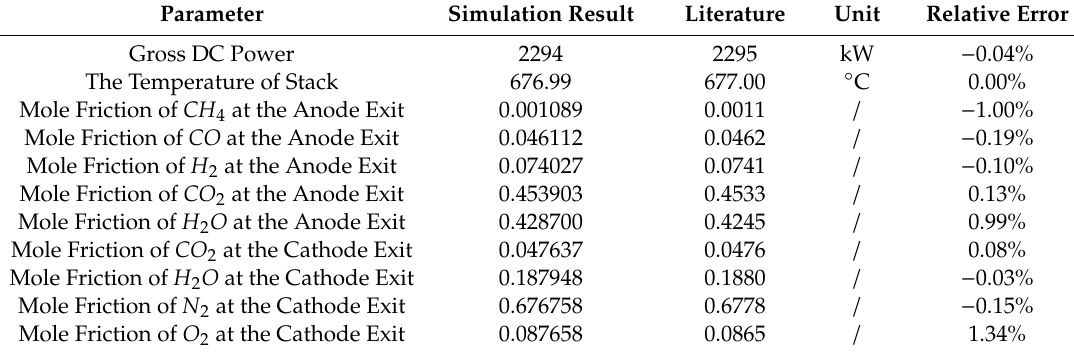
Figure 5. The exhaust gas temperature, output power, and efficiency comparison between the simulation and design values [24] at air inlet temperatures ranging from − 20 ◦ C to 45 ◦ C. Table 3. Comparison of the MCFC parameters between the literature [25] and the simulation results.